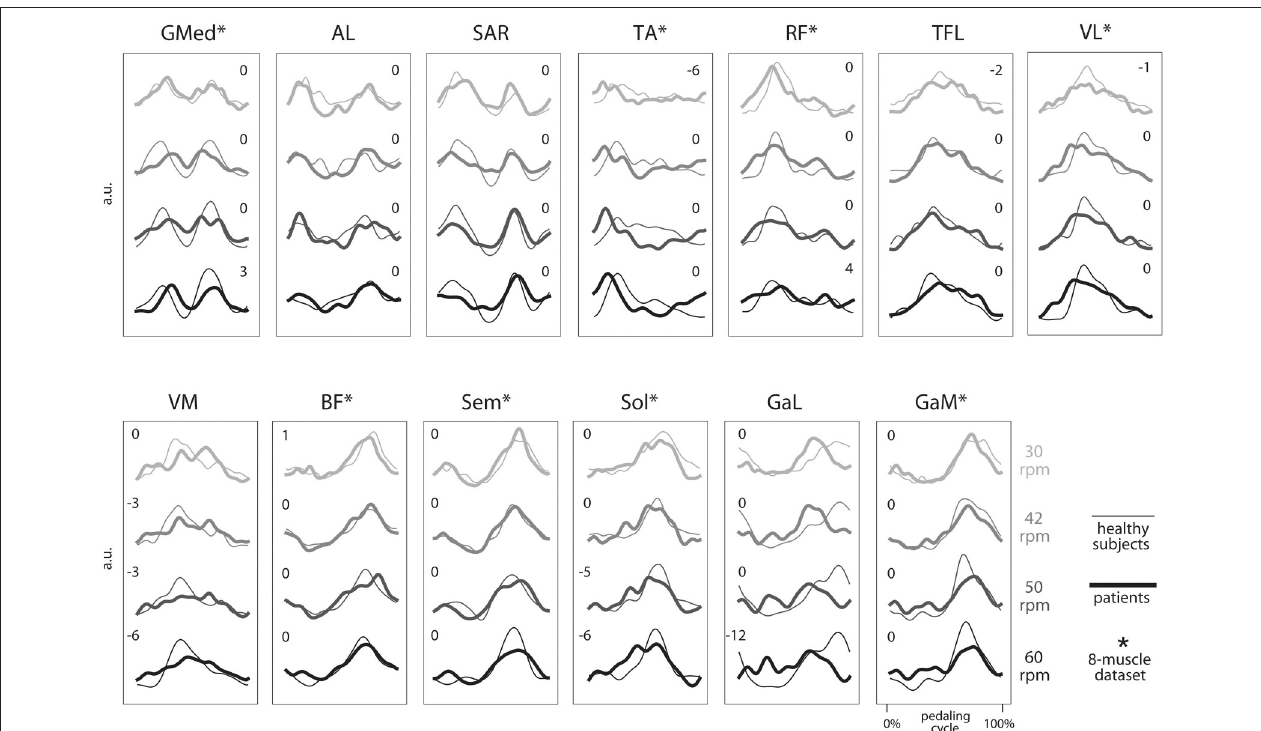
FIGURE 1 | Group average electromyographic (EMG) envelopes of the 13 recorded muscles for each of the four speeds during cycling (30, 42, 50, and 60rpm). For each group (healthy subjects, thin lines; iSCI patients, thick lines), a total of 100 cycling cycles (10 cycles by subject) were averaged and expressed as a function of the pedaling cycle. Pedaling cycle begins when the pedal corresponding to the dominant leg (in healthy subjects) or the most affected leg (in iSCI subjects) is at the lowest position and ends when the pedal reaches the lowest position again. EMGs from each subject and muscle were previously normalized by the average of its maximum values throughout the 10 cycles. a.u., arbitrary unit. * , muscles belonging to the eight muscles set used in parallel analysis. Number indicate lag times that maximized the cross-correlation function. A negative value indicates that the mean EMG envelopes of iSCI patients shifted earlier in the cycle relative to the mean EMG envelopes of healthy